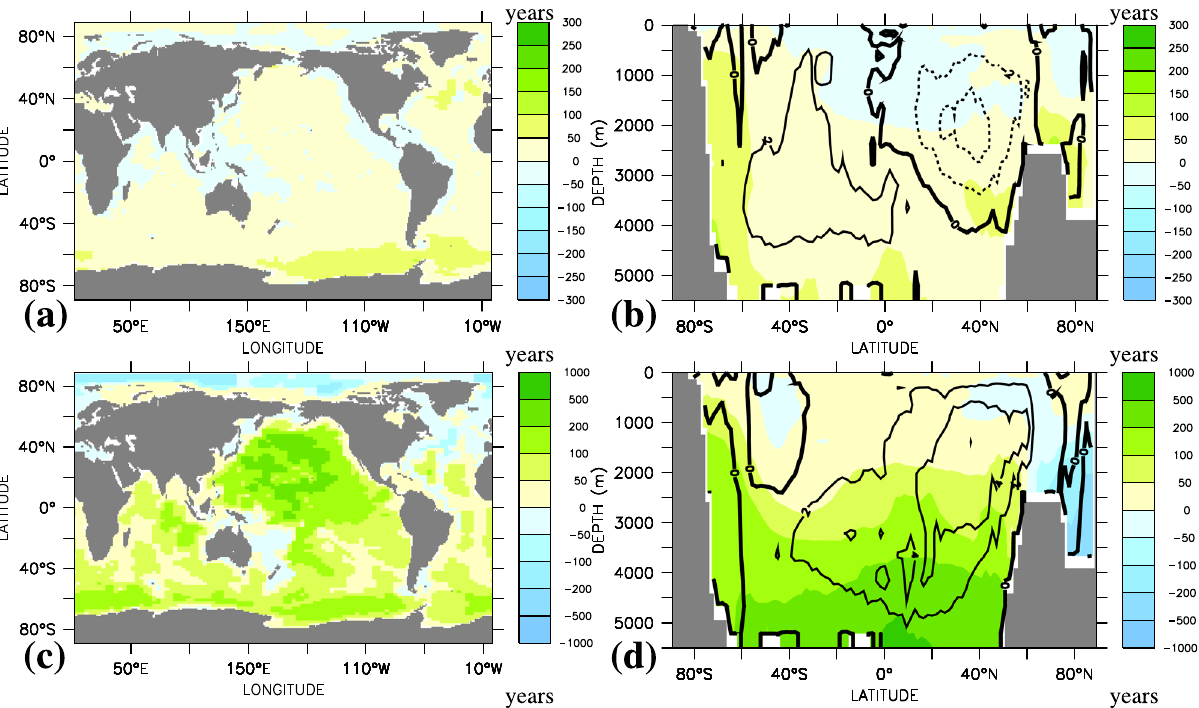
Fig. 3 Changes in ideal age. Simulated changes in vertically and zonally averaged water age for a , b year 2020 minus year 1800 and c , d year 2650 minus year 2020. Contours in b and d are changes in the overturning stream function (units Sv, with increments of 2 Sv) over the same time intervals. Table 1 Simulated changes in dissolved